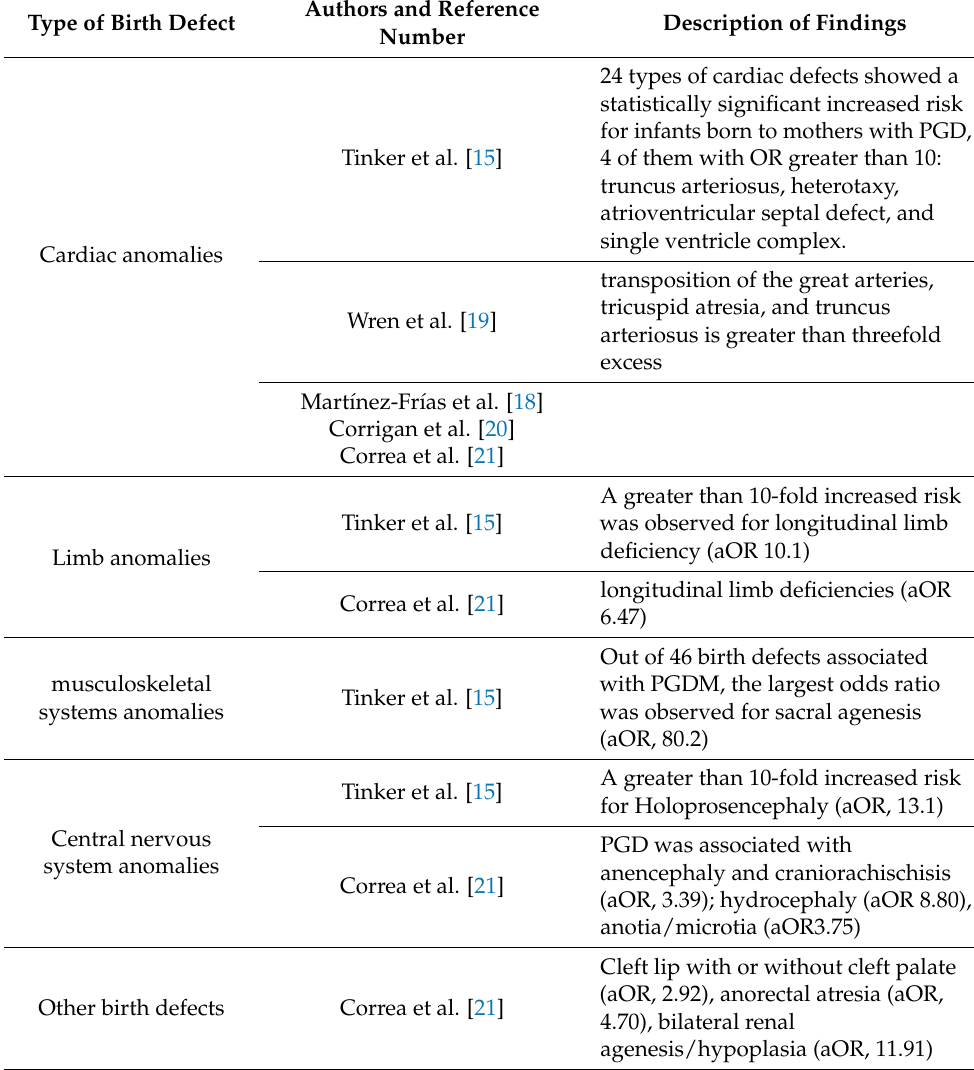
Table 1. Types of congenital malformations in the offspring of mothers with pregestational diabetes mellitus